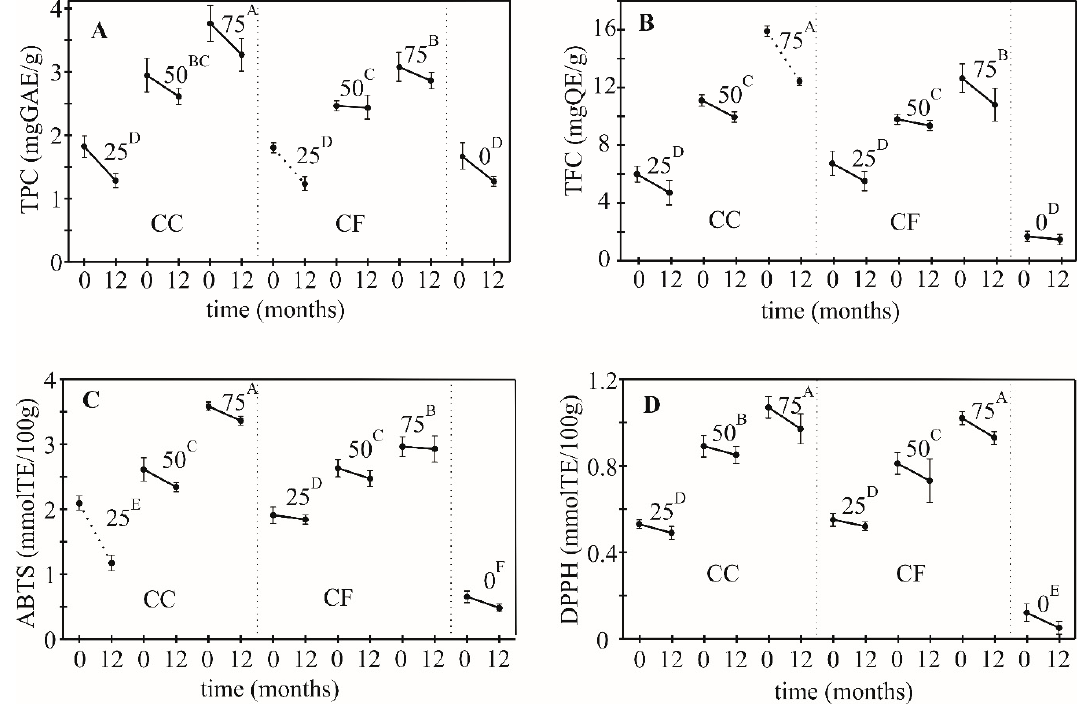
Figure 3. Decrease of TPC ( A ), TFC ( B ), scavenging of ABTS ( C ) and DPPH ( D ) test during 12 months storage of cookies (CC—cookies with coarse APF, CF—cookies with fine APF) in relation to the percentage of wheat flour substituted with APF (25%, 50% and 75%; different superscripts indicate significant differences of means, according to Tukey’s HSD test ( p < 0.05), dashed line indicates the significant drop in value after 12 months ( p < 0.05)).